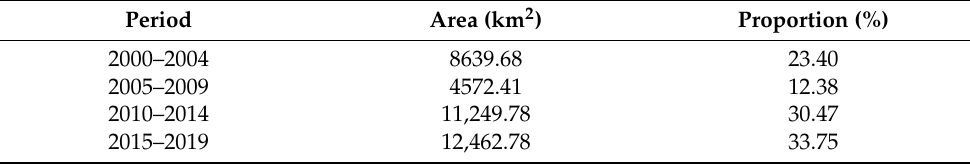
Table 8. Area and proportion of afforestation in Chongqing in different time